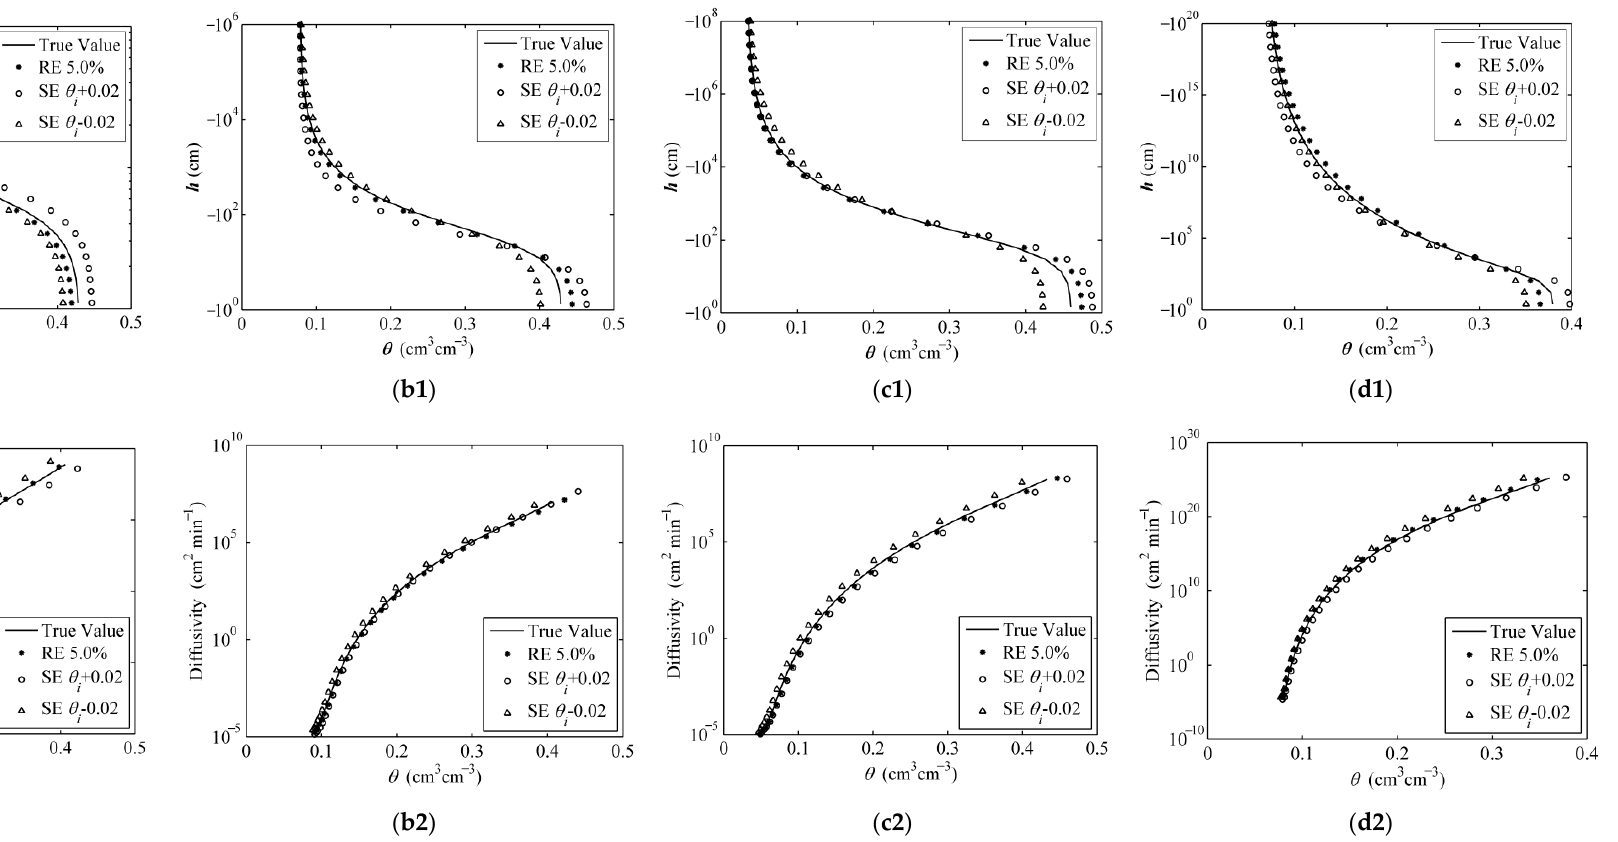
Figure 9. Comparison of SWRCs ( a1 , b1 , c1 , d1 ) and diffusivity curves ( a2 , b2 , c2 , d2 ) with system and random errors for different treatments and calculation using the objective function f ( θ final ) (circle: 5.0% random error; triangle: 2.0% system error; square: − 2.0% system error; line: true value): ( a ) sand; ( b ) loam; ( c ); silt; ( d ), and clay.